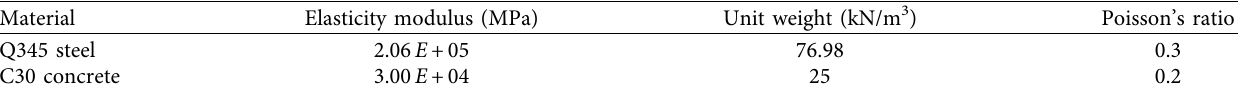
Figure 4: Steel stress-strain diagram. Table 1: Material parameters of steel shell and pier.